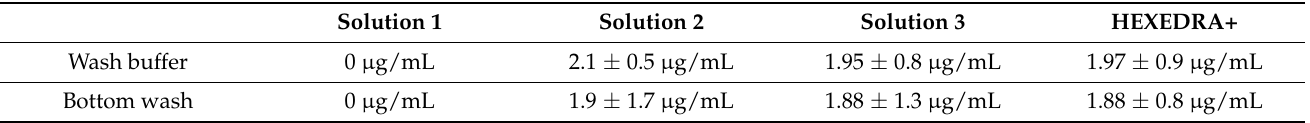
Table 1. UA spectrophotometry quantification at 281 nm by Tecan (Infinite 200 Pro MPlex, Tecan, Milan, Italy) and data are expressed as µg/mL± SD of four independent experiments. Solution 1 = 150 mcg/mL β -CD + HPMC; Solution 2 = 150 mcg/mL UA + 150 mcg/mL β -CD + 1%